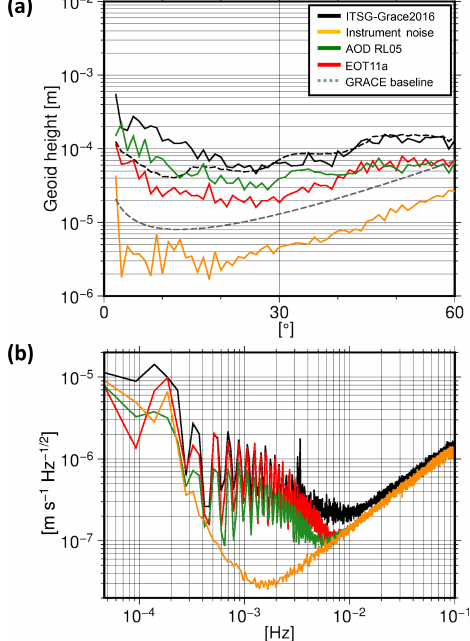
Figure 13. (a) RMS geoid heights per degree from simulated and real solutions with respect to the reference field GOCO05s. (b) PSD of the residuals from simulated and real data for February